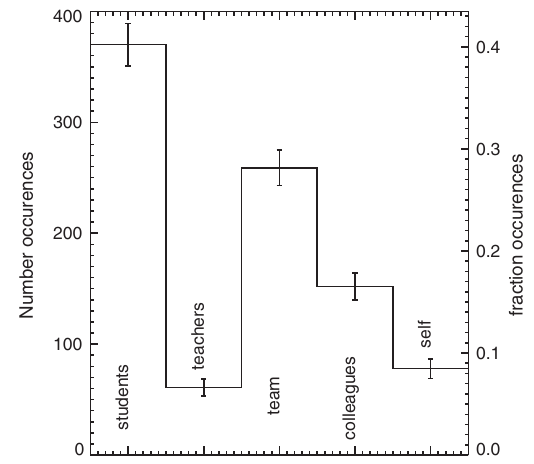
FIG. 1. Number of instances (left axis) and rate (right axis) of each of the five encoding words used to probe the inward or outward facing stance of educators. Students , 370 (40%); teachers , 61 (6.6%); team , 259 (28%); colleagues , 152 (17%); self , 78 (8.5%). Uncertainties as shown correspond to the left axis and assume Poisson counting statistics; fractional uncertainties are ≤ 3% , again assuming Poisson errors. Students and teachers are more outward focused, and colleagues and self are more inward focused. Students is, by far, the most common word in the encoding.